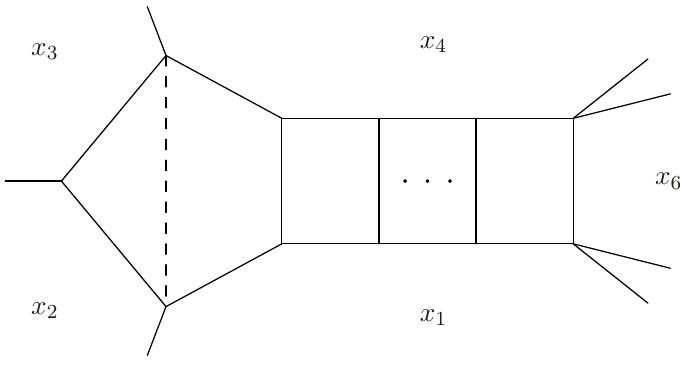
Figure 6. The seven-point pentabox ladder integral, labeled by dual coordinates, in which the box ladder involves L − 1 loops. The dashed line represents a numerator factor that renders the integral DCI and infrared finite. This class of integrals maps into the space of functions relevant for the three-point form factor in the limit x 6 → ∞